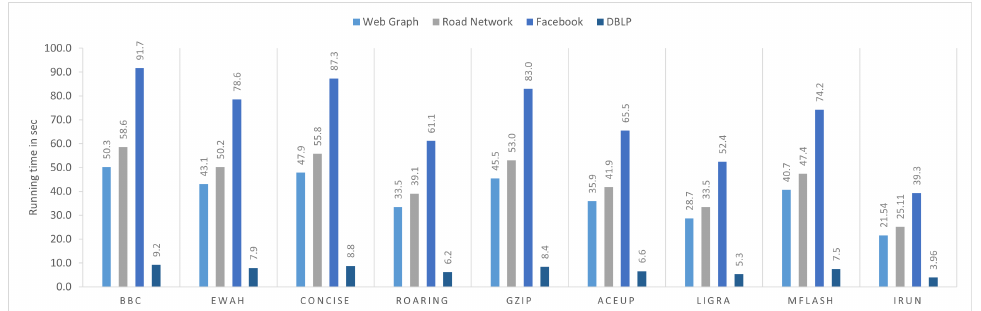
Figure 7. Processing